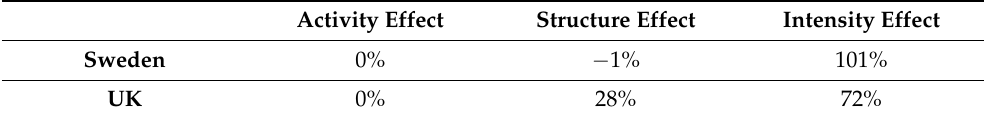
Table 5. Percentage contributions of activity, structure and intensity effects to overall change in final energy per household between 2010 and 2050 for heating in Sweden and the UK derived from ‘1.5C Total’